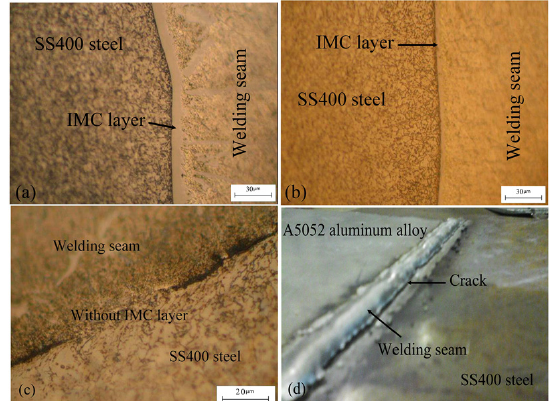
Figure 5. Microstructure of welded A5052 aluminum alloy/SS400 steel sheet for a welding intensity of 95 A and a welding speed of 3.5 to 4 mm/s: ( a ) IMC layer zone on the top side; ( b ) IMC layer zone on the bottom side; ( c ) without the IMC layer zone; and ( d ) cracking after welding.